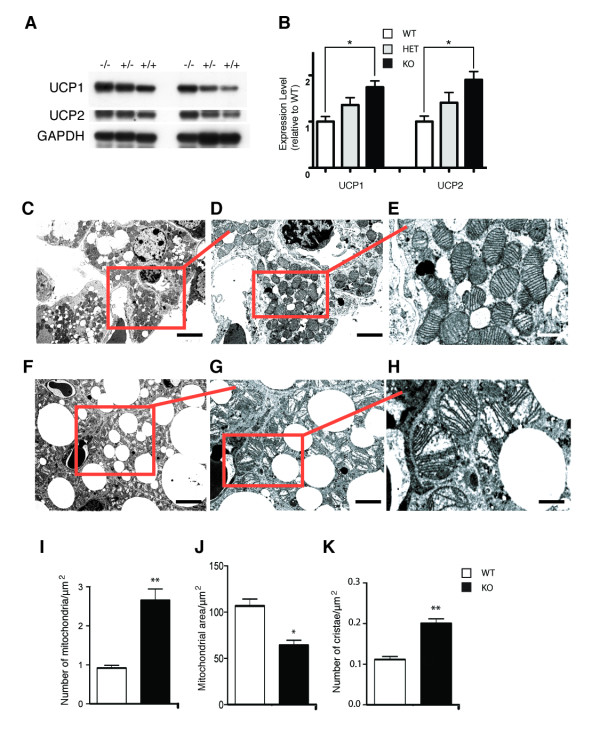
VGF ablation affects UCP1 & UCP2 protein expression, mitochondrial morphology, and mitochondrial number in BAT. Representative western blots of UCP1, UCP2, and GAPDH protein levels in BAT from VgfR +/+, +/-, and -/- mice (panel A), and densitometric quantification by NIH image (panel B). Comparable results were found in at least three additional experiments. Ablation of VGF significantly increased UCP1 and UCP2 levels in BAT from VgfR -/- but not VgfR +/- mice compared to wild type +/+ mice [n = 5 mice per group, mean ± SEM, F (2,12) = 4.35 (UCP1), F (2,12) = 3.33 (UCP2), *p < 0.05, ANOVA and Dunnett's posthoc test]. Representative electron microscope photomicrographs of BAT from VgfR -/- (panels C-E) and +/+ mice (panels F-H) are shown. The part of the image that is boxed in red is shown at higher magnification in the panel to its immediate right. Scale bars are 5 μm (panels C and F), 2.5 μm (panels D and G), and 1.25 μm (panels E and H). Note that mitochondria are smaller and more numerous in VgfR -/- in comparison to +/+ BAT (compare panels E and H), which is quantified in panels I and J. In panel K, the number of cristae per μm2 of mitochondrial area was quantified in VgfR -/- and +/+ BAT. Values are mean ± SEM; ***p = 0.0002 (panel E), **p = 0.001 (panel F), ***p < 0.0001 (panel G) (Student's t-test).